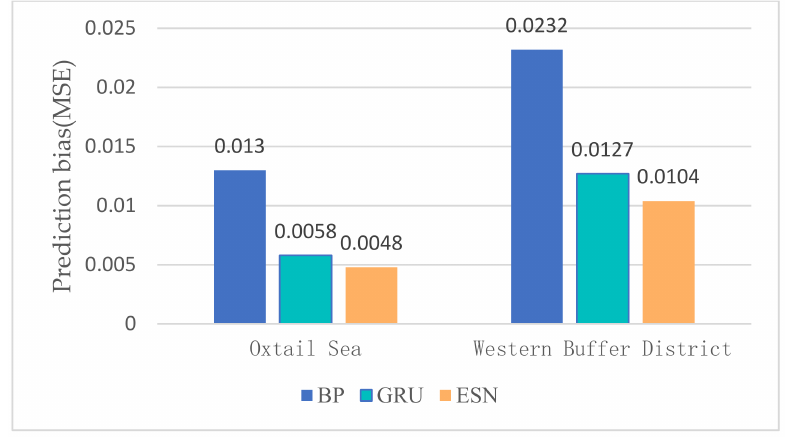
Figure 10. Comparison of prediction bias of different water quality prediction models.